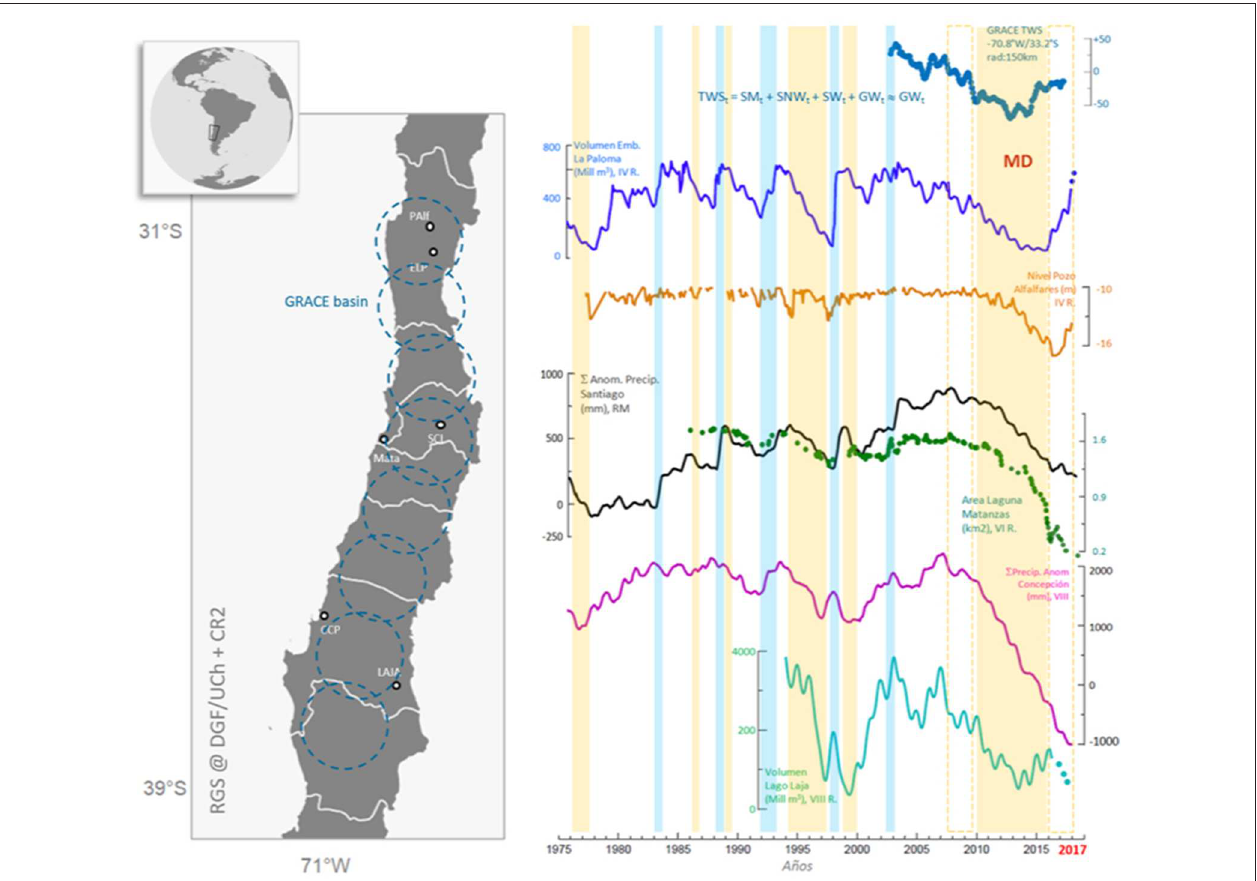
FIGURE 14 | Evolution of the water volume in selected reservoirs in central Chile (extratropical Andes) during the last four decades. Dry periods are marked by the yellow vertical bars. The ongoing megadrought is the dry spell that began in 2010.